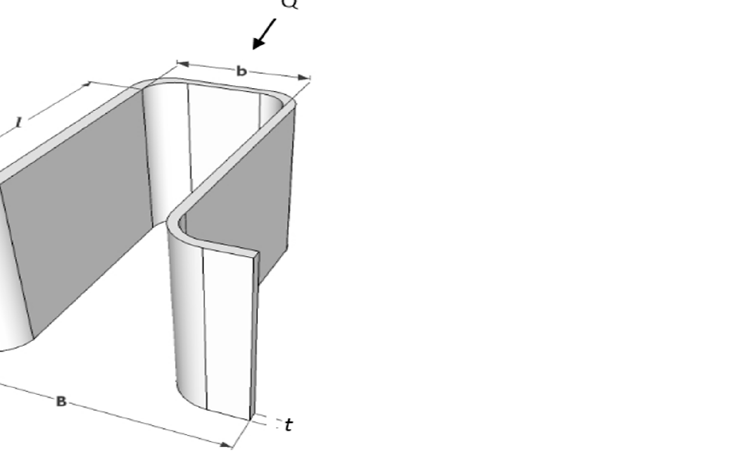
Figure 1. Isometric view of round-cornered rectangular labyrinth weir and definition of the main symbols.